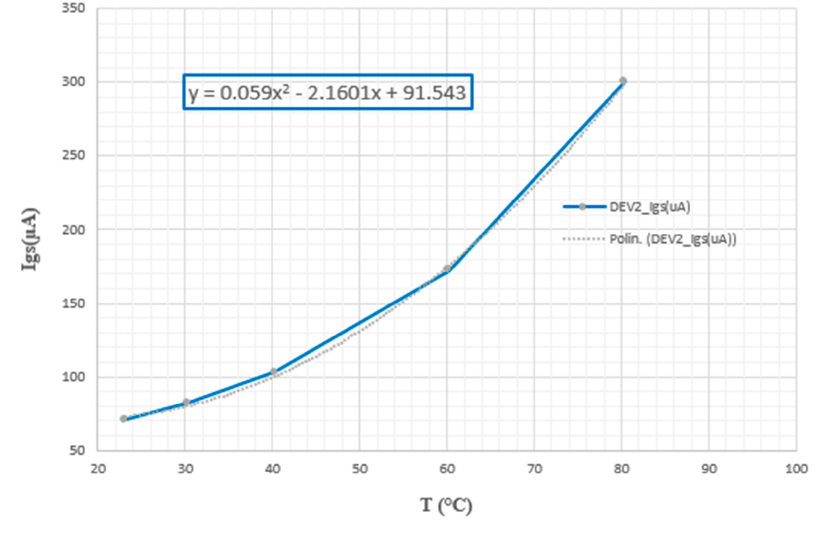
Figure 16. Calibration curve of I g.